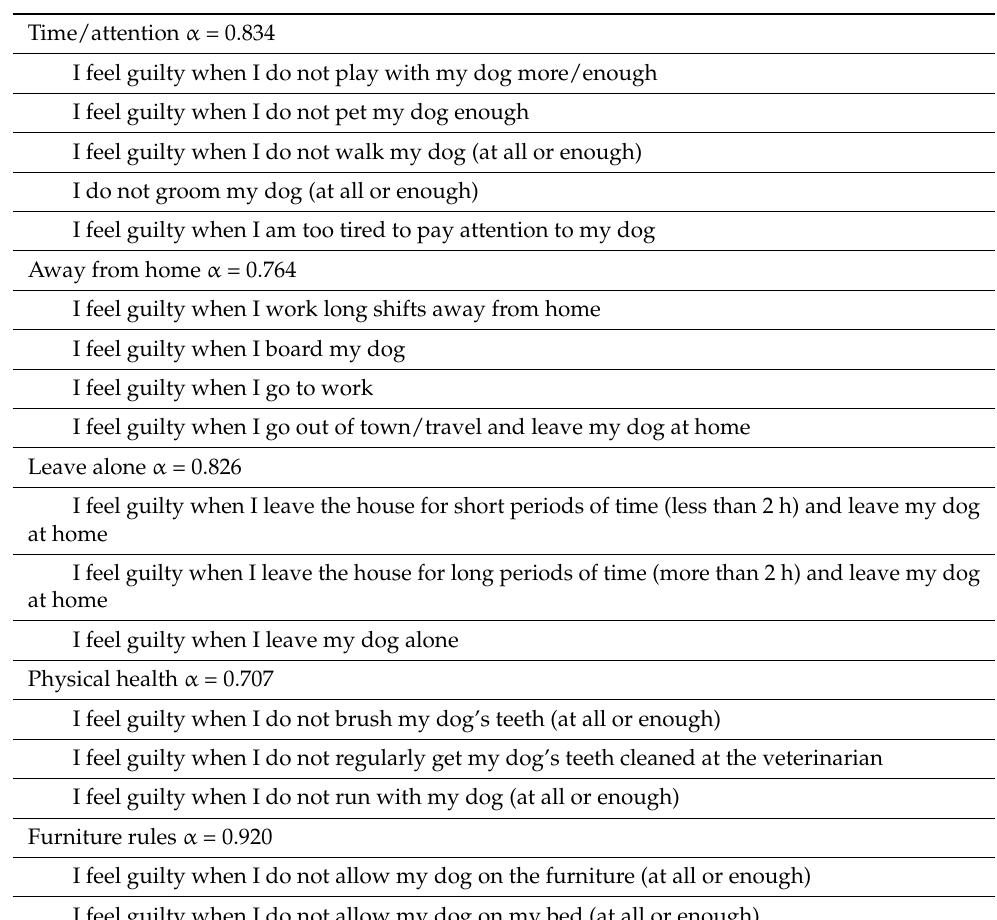
Table 3. Factor analysis—five dog-related guilt